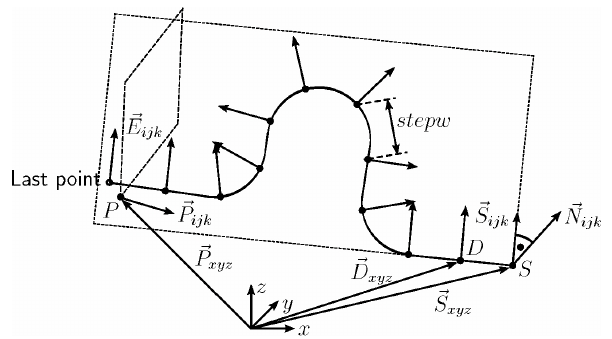
Figure 10. Principle and parameters of free-form scan function “ScanInPlaneEndIsPlane”.